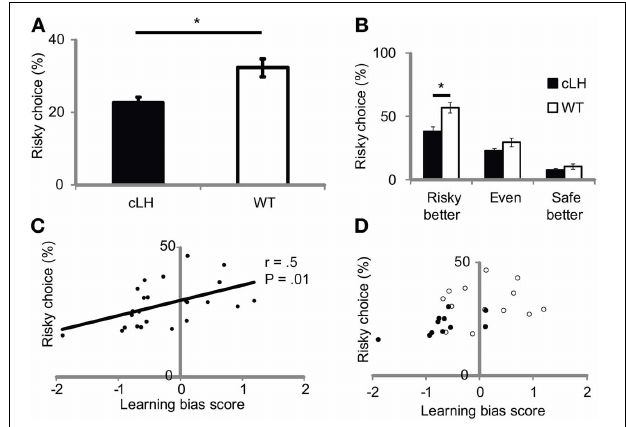
FIGURE 2 | Risk-averse choice in cLH rats and its relationship to negative learning bias. (A) cLH rats chose the variable/risky side less than WT rats (averages of variable/risky better, even, and constant/safe better conditions used for comparison between groups). (B) cLH rats chose the variable/risky side less than WT rats in the variable/risky better condition, when risk was greatest. (C) Learning bias is correlated with risky choice. (D) Same as (C) with symbols denoting cLH (filled circles) and WT (open circles) groups. ∗ P < 0 . 01. Student’s t -test. Error bars indicate